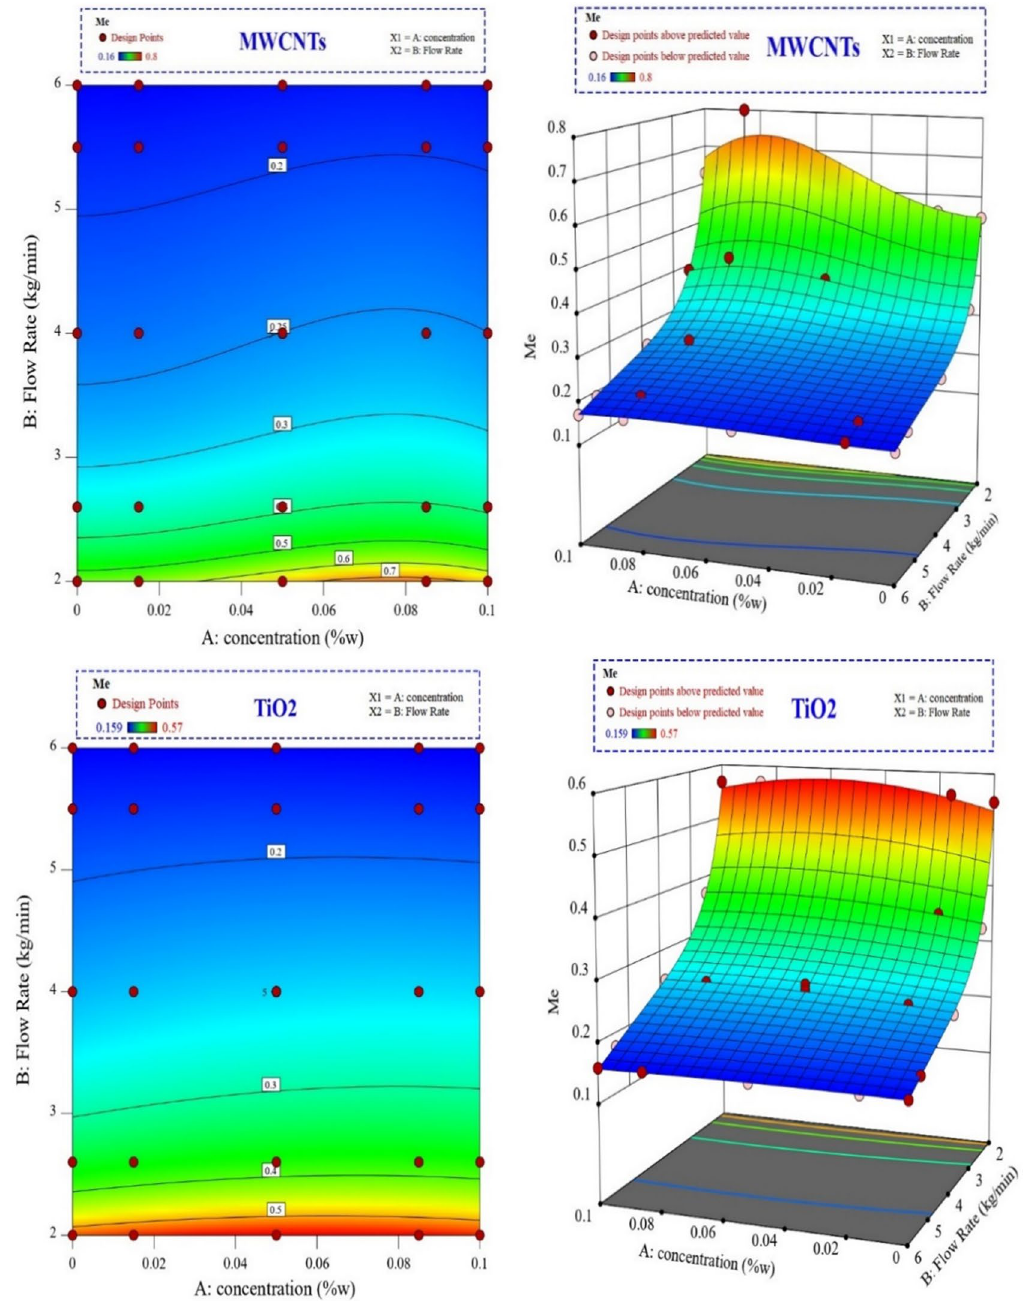
Figure 15. The influence of MWCNTs and TiO 2 nanofluid concentration and flow rate on the Merkel number of CFCT in three-dimensional and contour